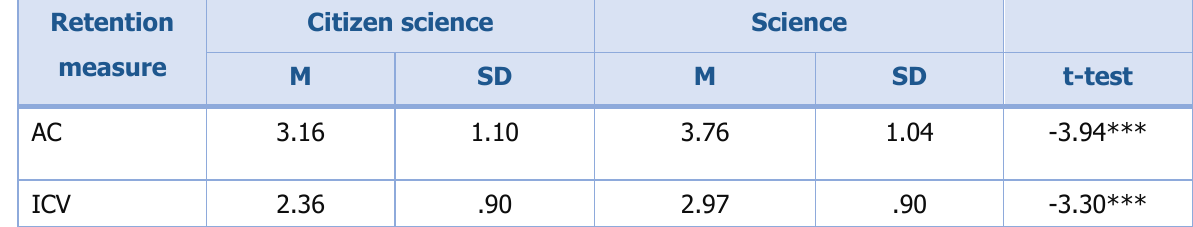
Table 5: Independent Sample t-tests between 4-H Science and 4-H Citizen Science Program and Affective Commitment (AC) and Intention to Continue Volunteering (ICV)